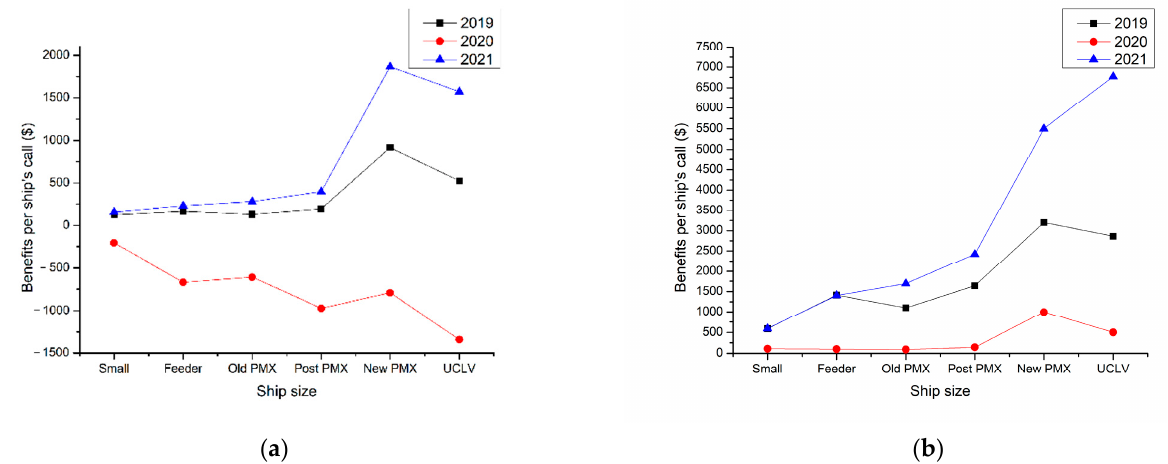
Figure 4. ( a ) Benefits per ship’s call (HSFO) and ( b ) benefits per ship’s call(MGO).